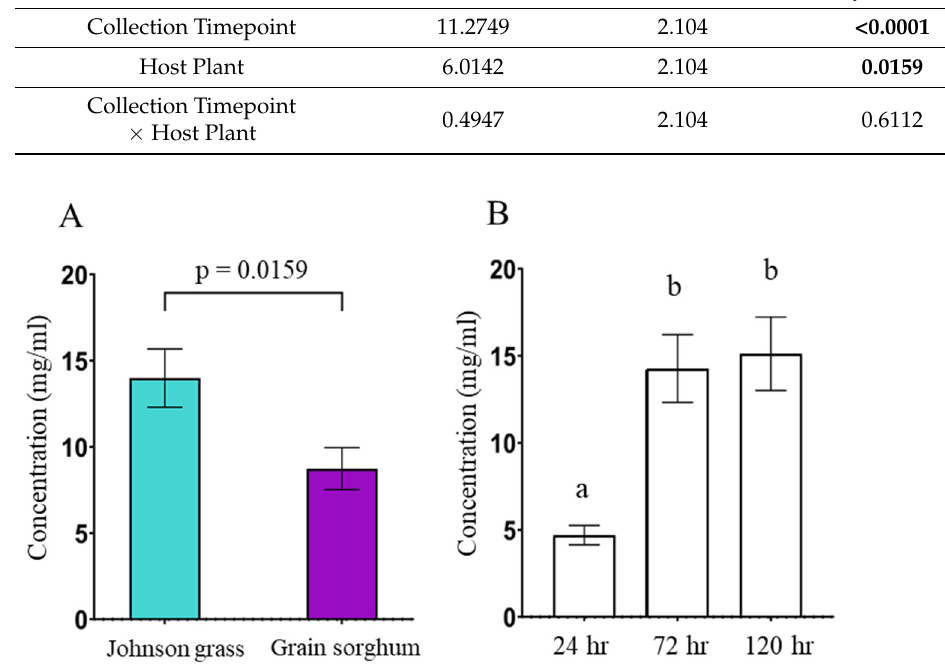
Figure 1. ( A ) Overall, sugar concentration is greater in honeydew from Johnson grass aphids